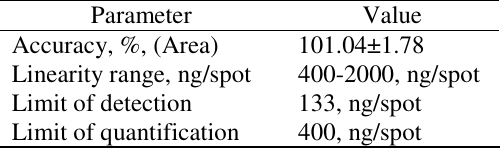
Figure 2 . Overlay absorption spectra of Standard cefprozil & cefprozil from tablets Table 5 . Method validation